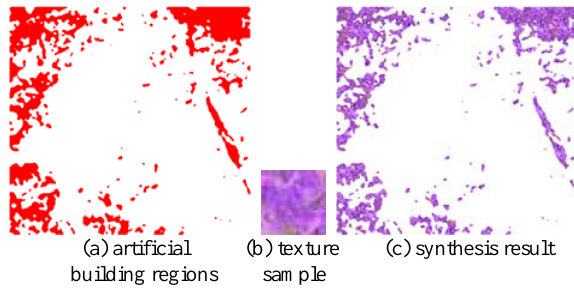
Figure 10. Translation of artificial building class